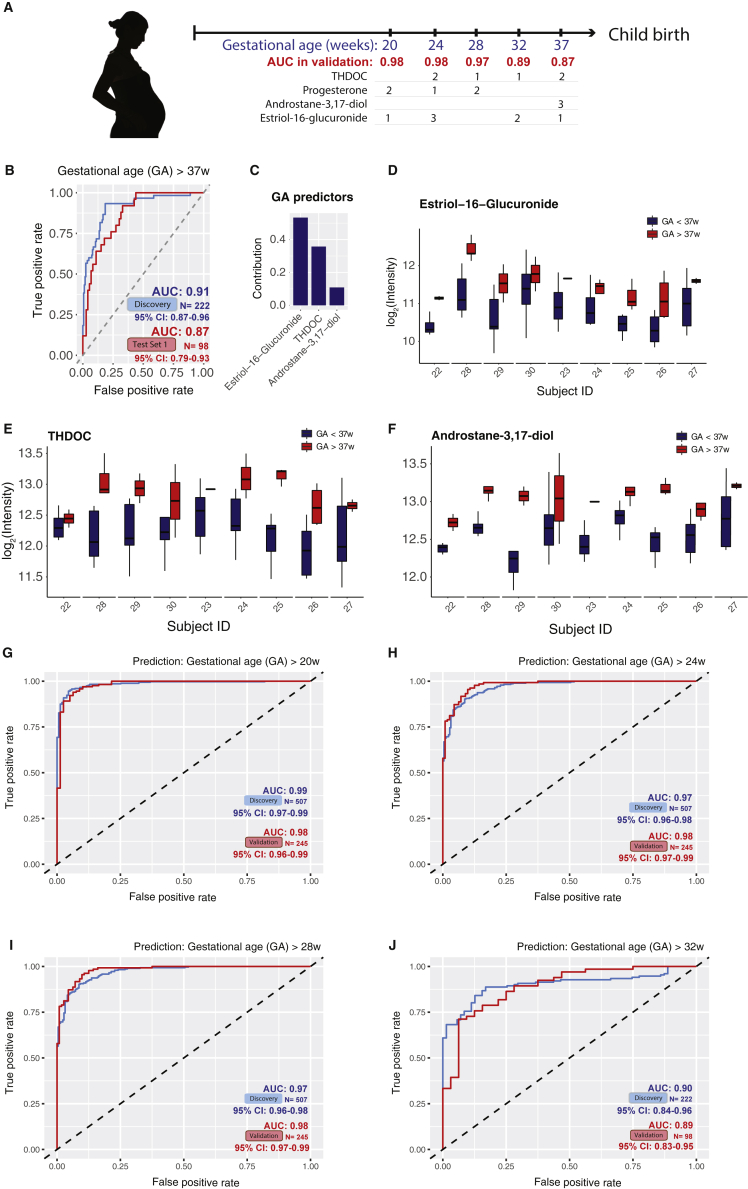
Metabolites Selected by Machine Learning Can Accurately Predict Gestational Age before or after 20, 24, 28, 32, and 37 Weeks in Both the Discovery and Validation Cohort (Test Set 1), Related to Figure 4(A) Summary of prediction models of gestational age (GA) before or after 20, 24, 28, 32, and 37 weeks, using two to three metabolites. Note that the prediction models for 20, 24, and 28 gestational weeks were built using samples from all three trimesters and the ones for late pregnancy (32 and 37 weeks) were build using third-trimester samples. The contribution rank of each predictor in every model is listed as number 1, 2, and 3. Area under the curves (AUCs) in the validation cohort (Test Set 1) are listed.(B) The logistic regression model based on three metabolites can accurately distinguish the third-trimester plasma samples before or after 37 weeks.(C) Contribution of the three metabolites to the prediction model of gestational age before or after 37 weeks.(D) Estriol-16-Glucuronide shows intensity range separations before and after 37 weeks.(E and F) THDOC and androstane-3,17-diol show intensity range separations before/after 37 weeks.(G–J) The logistic regression models can accurately distinguish pregnancy samples before or after 20 (G) 24 (H), and 28 (I) weeks, and the third trimester plasma samples before or after 32 weeks (J). GA, gestational age.